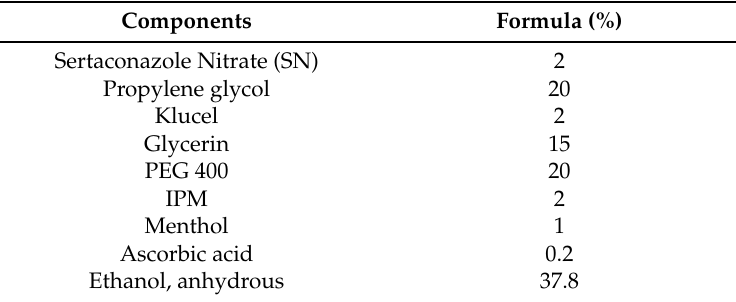
Table 2. Anhydrous gel